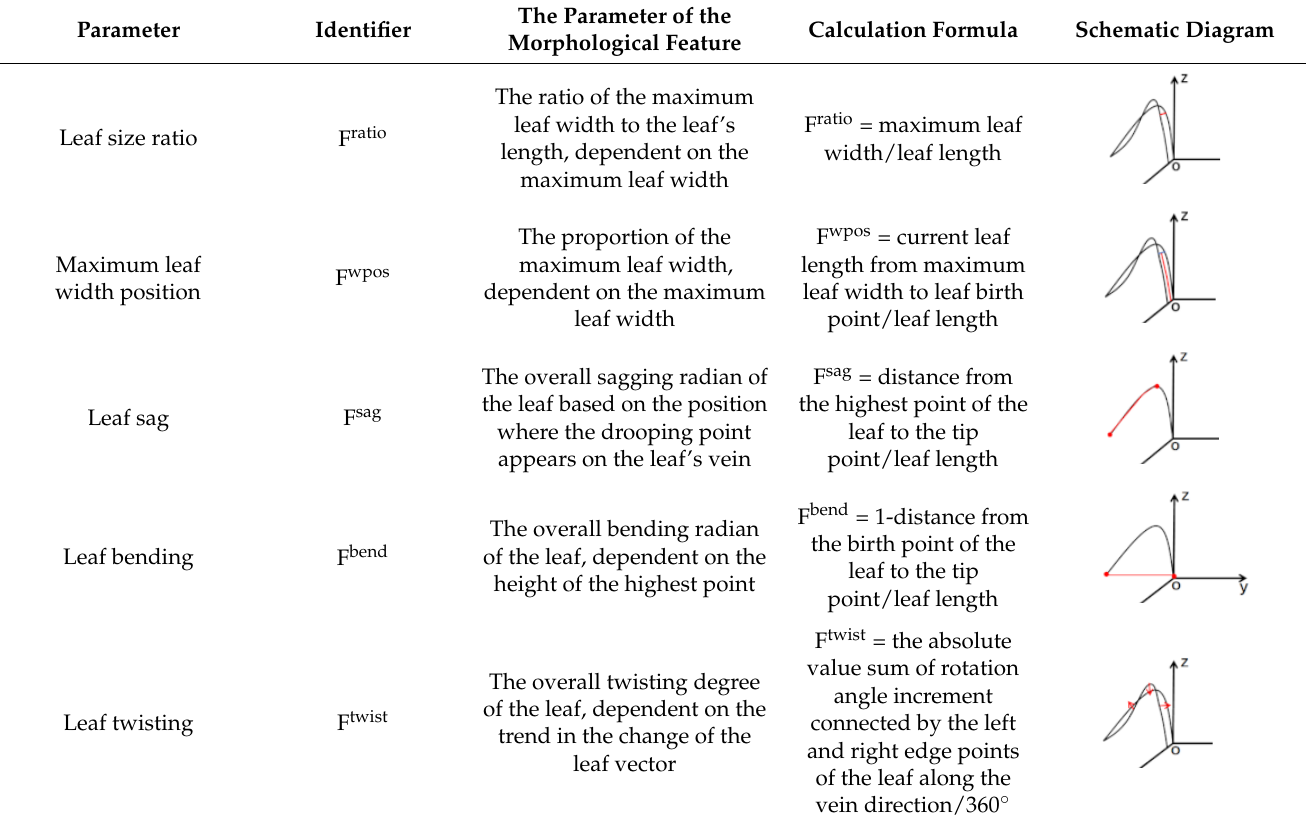
Table 2. Calculating specific parameters of the five morphological leaf